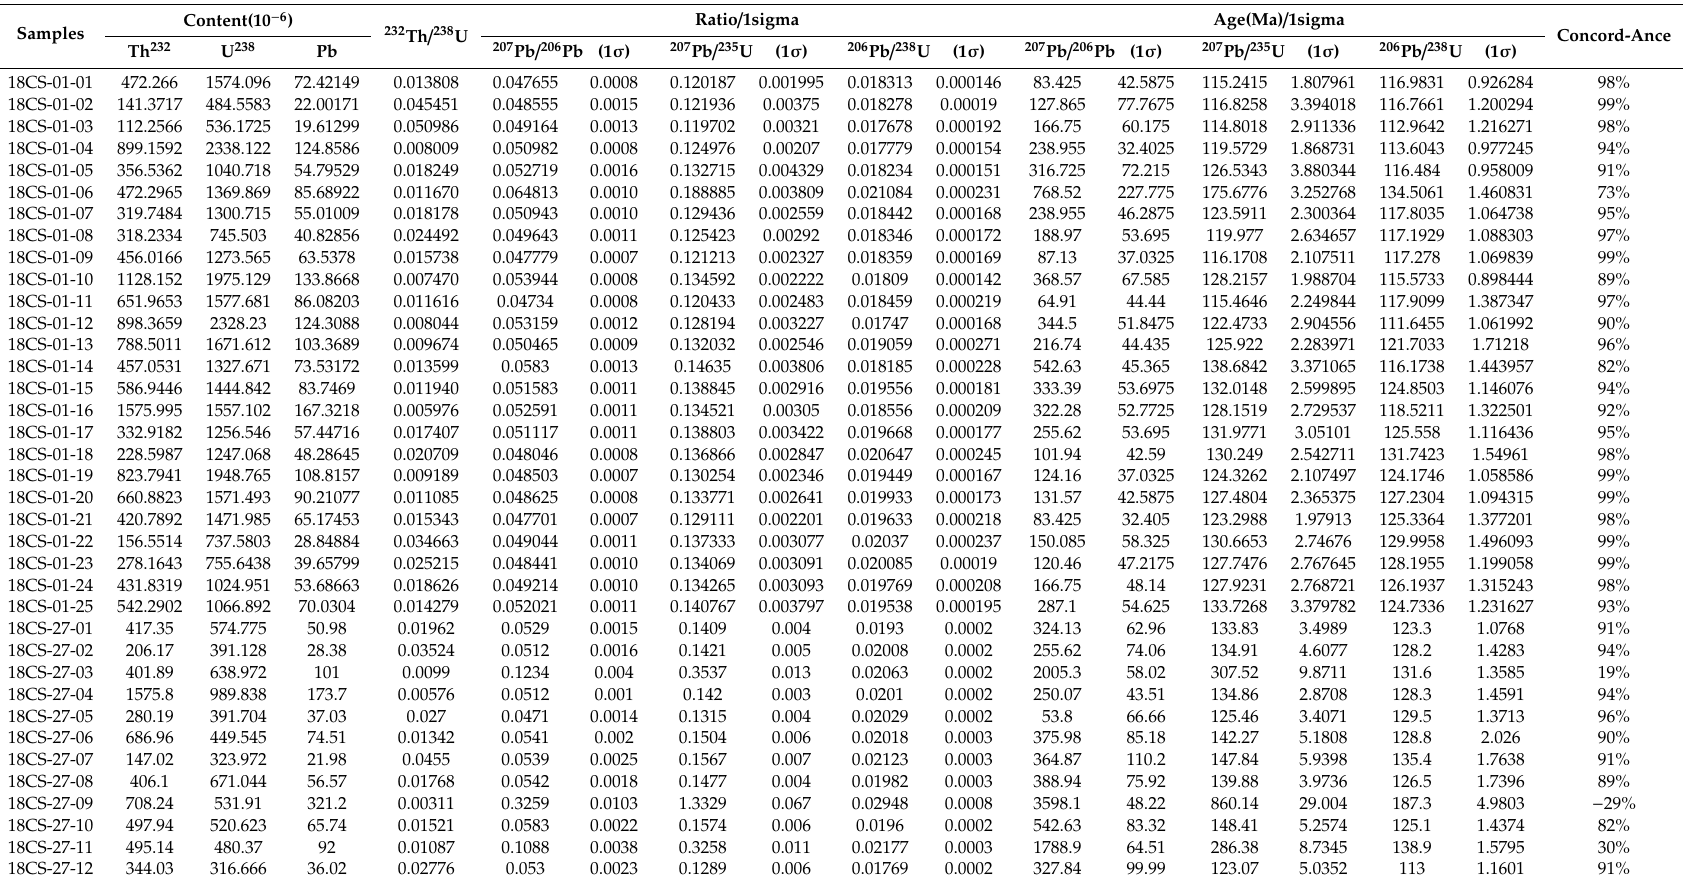
Table 2. Zircon U–Pb dating data of the Chishan alkaline